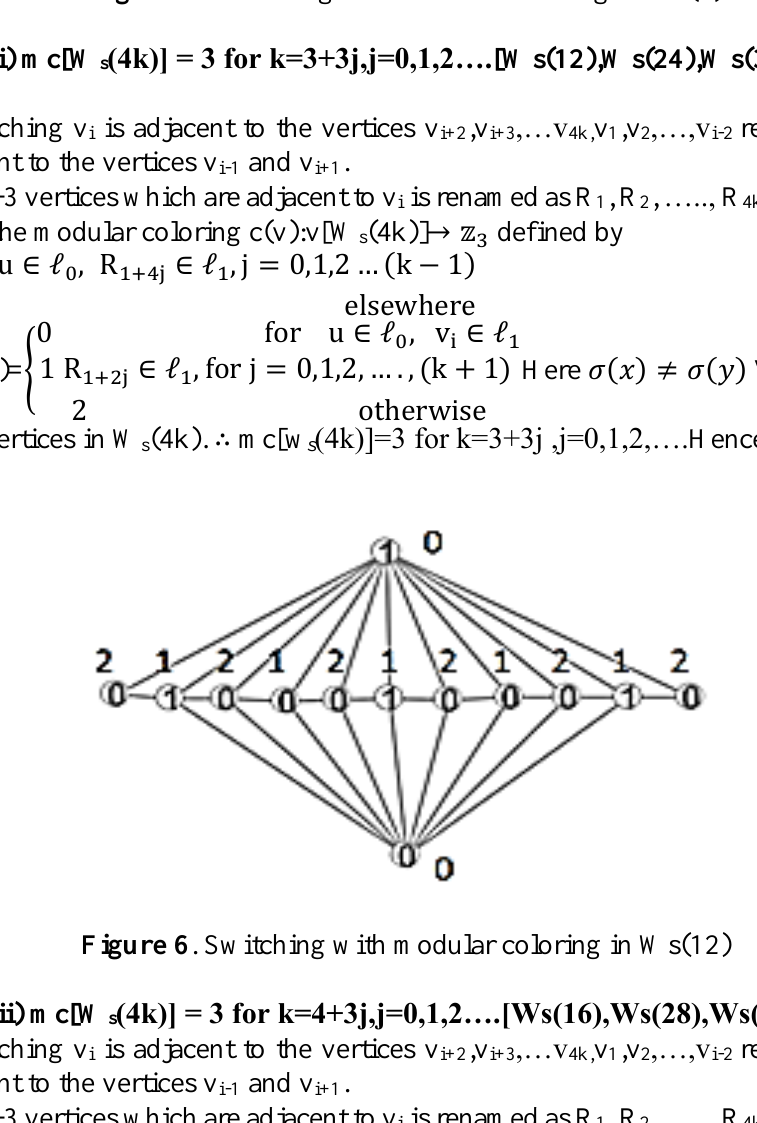
Figure 5 . Switching with modular coloring in Ws(8)